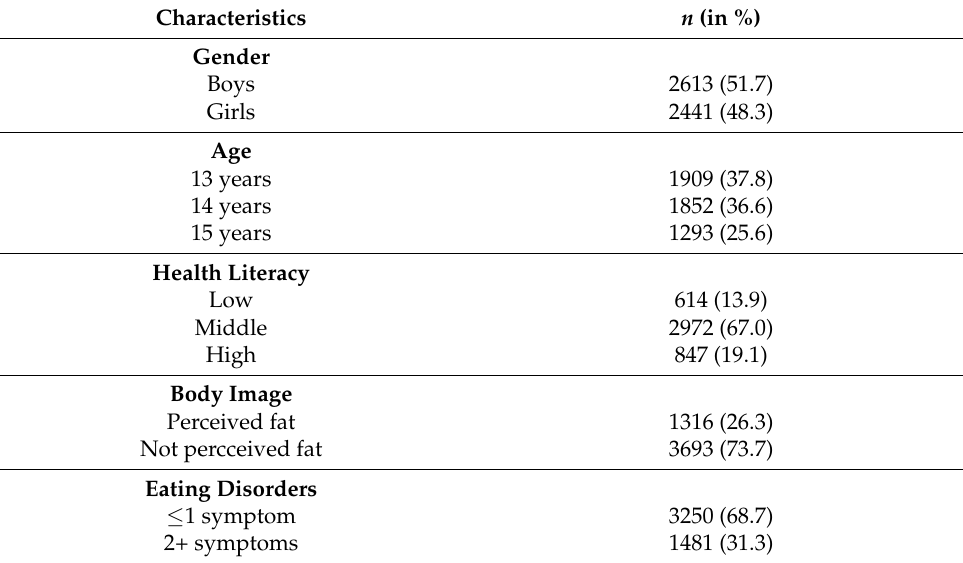
Table 1. Description of the sample (Slovakia 2018, 13–15-years-old, n = 5054).